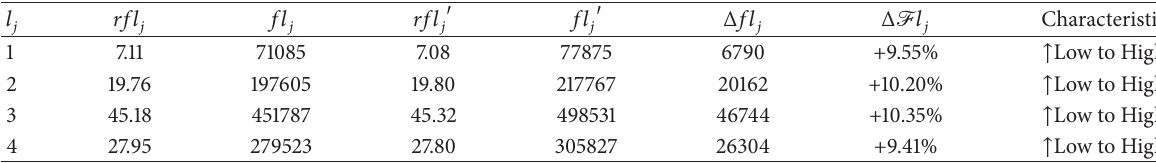
Table 19: Characterization of malicious attacks on length of data values